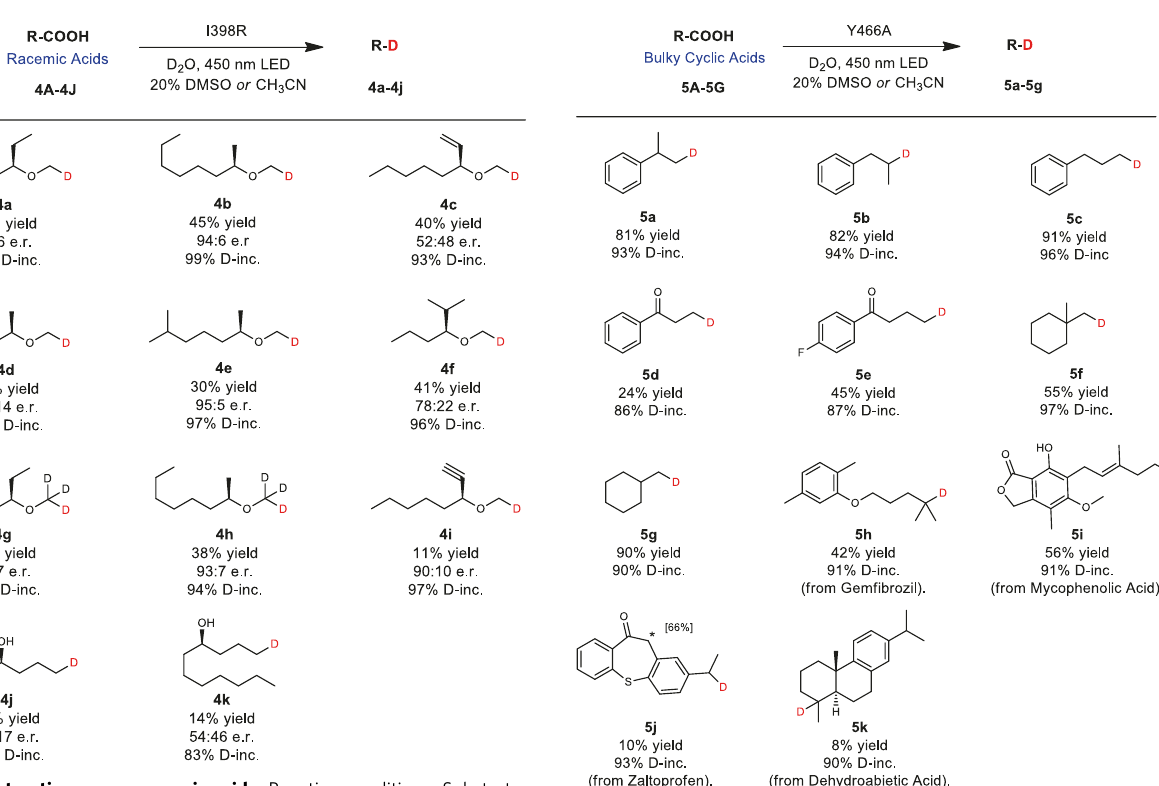
Fig. 5 Deuteration scope: racemic acids. Reaction conditions: Substrate (0.40 mmol), crude enzyme powder (containing Cv FAP about 20 mg), D 2 O (4 mL), DMSO or CH 3 CN (1 mL), 450 nm LED, 20 °C, 12 h. Yields and e.r. values were determined by chiral GC. D-inc. data were determined by 1 H NMR or HRMS. E.r. value of 4e was calculated based on the conversion and e.r. of 4E